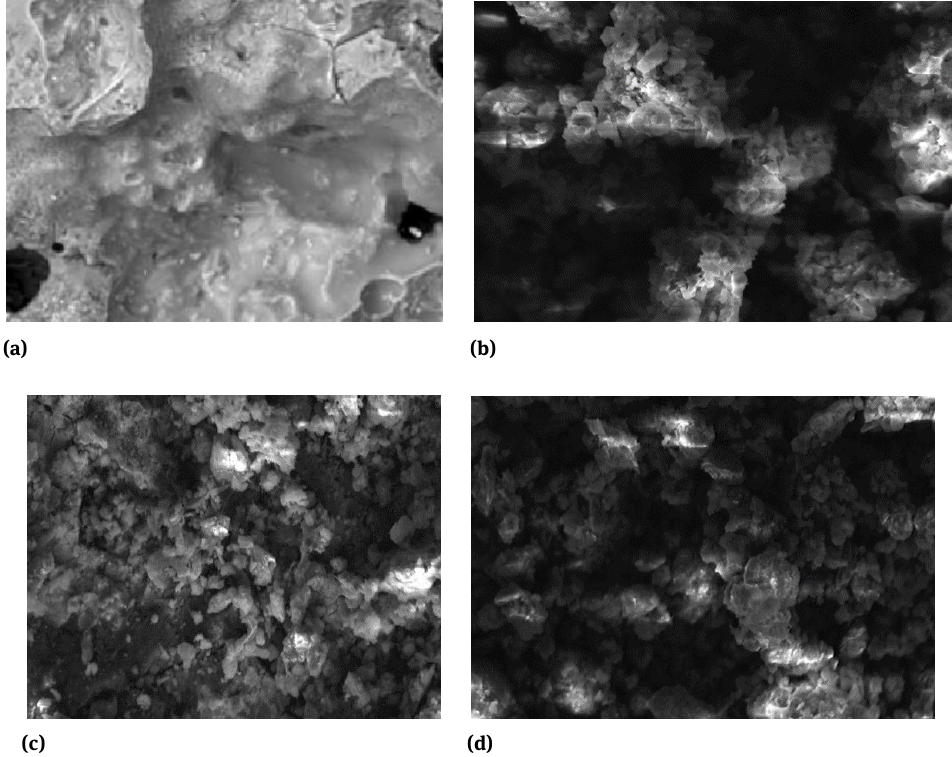
Figure 2: Morphology a. Pure OPBA ,b .OPBA with NaOH 2M c .OPBA with NaOH 2,5M d.OPBA with NaOH 3M